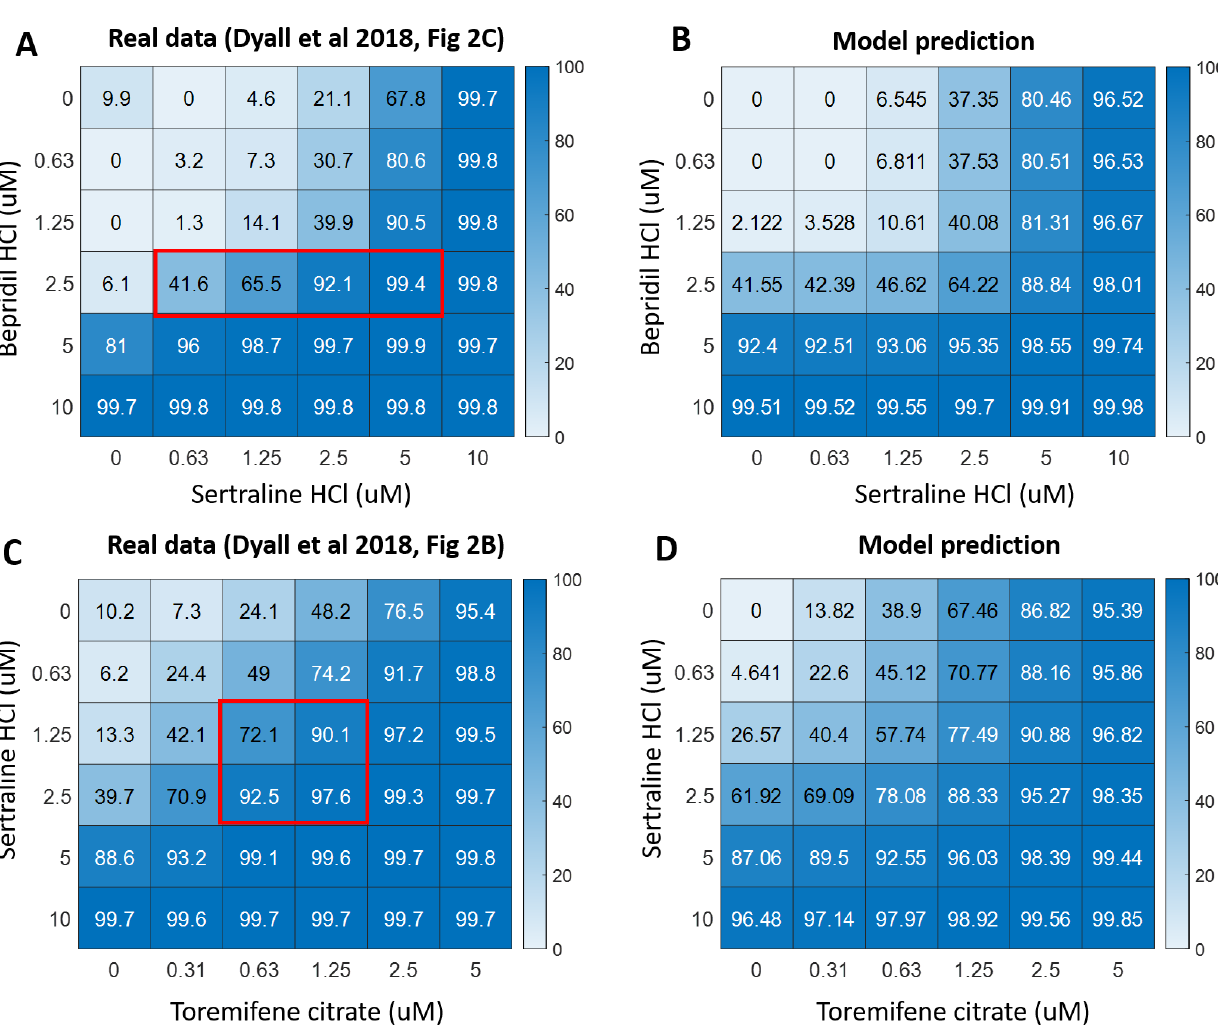
Figure 6. Empirical and projected efficacies of drug combinations. ( A , C ) Empirically quantified efficacies of (bepridil HCl + sertraline HCl) and (sertraline HCl + toremifene citrate) in Huh7 cells [22]. Highly synergistic regions are highlighted in red boxes, which have ∆ Bliss values < − 0.3. ( B , D ) Model-projected efficacies of (bepridil HCl + sertraline HCl) and (sertraline HCl + toremifene citrate) using the Bliss model. Colors in each heatmap represent the percentage of inhibition, with 0 for no inhibition and 100 for complete inhibition of EBOV replication.